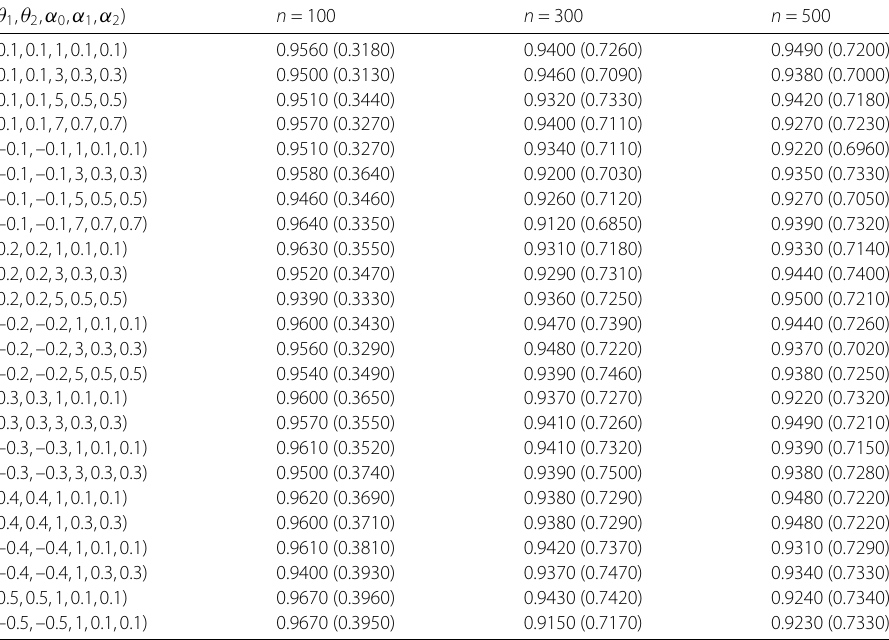
Table 4 The simulation results for sequence III ( (cid:9) , σ , k ) = (0.2,1,6) ( θ 1 , θ 2 , α 0 , α 1 , α 2 ) n = 100 n = 300 n = 500